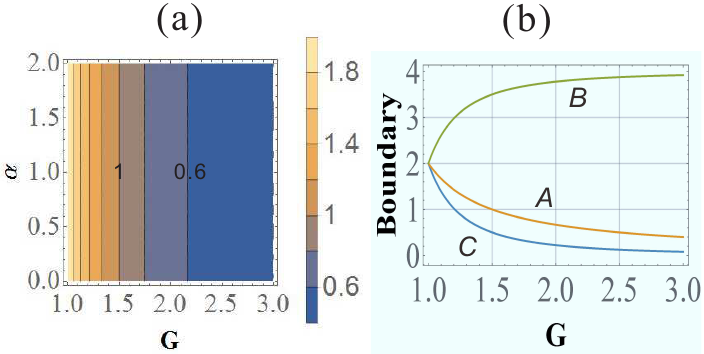
Figure 6. ( a ) The dependence of V opt B ); ( B 2 ) min = ( B 3 ) min (trace C